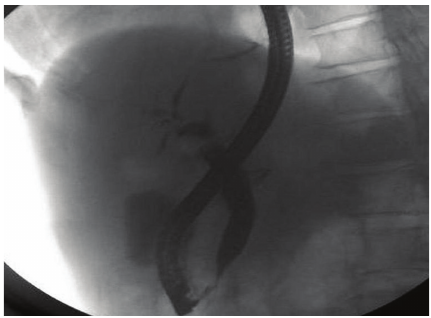
Figure 4: Endoscopic retrograde cholangiopancreatography. After endoscopic maior papillary sphincterotomy and drainage of blood clots mixed up with bile, cholangiography with iodinated contrast media retrograde injection shows mild bile ducts